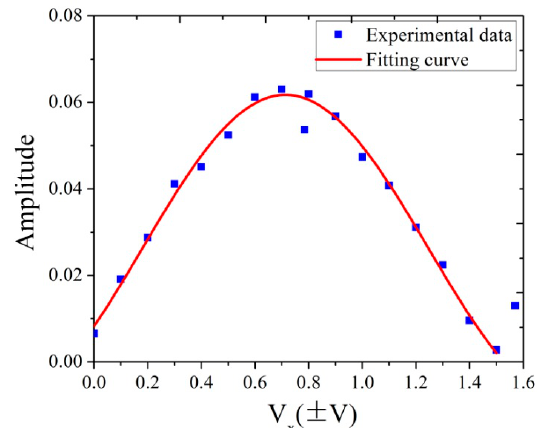
Figure 8. Result of experimental fitting. The horizontal axis represents the amplitude of the modulation voltage, and the longitudinal axis represents the amplitude of the fundamental voltage.